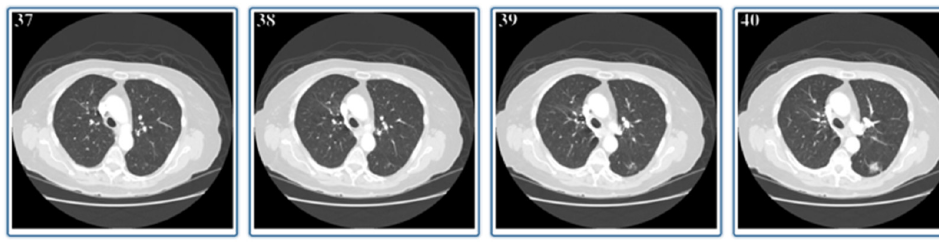
Figure 1. Four consecutive thoracic CT scans (of a total of 112 scans) for one individual of the LIDC. For the classification of any accumulated cell mass’s malignancy that is visible on CT scans, however, specialised machine learning (ML) applications could be used in the future [15,16]. In particular, deep learning (DL) methods and convolutional neural networks (CNNs) have demonstrated outstanding potential to analyse both feature-complex and large datasets [17], such as AlexNet [18], DenseNet [19], GoogLeNet [20]. Examples of models with outstanding performance on CT-lung scans include Resnet and FractalNet [16,17]. However, other approaches, such as deep local–global networks (DLGNs), too, have demonstrated remarkable lung nodule classification performance [18,19].